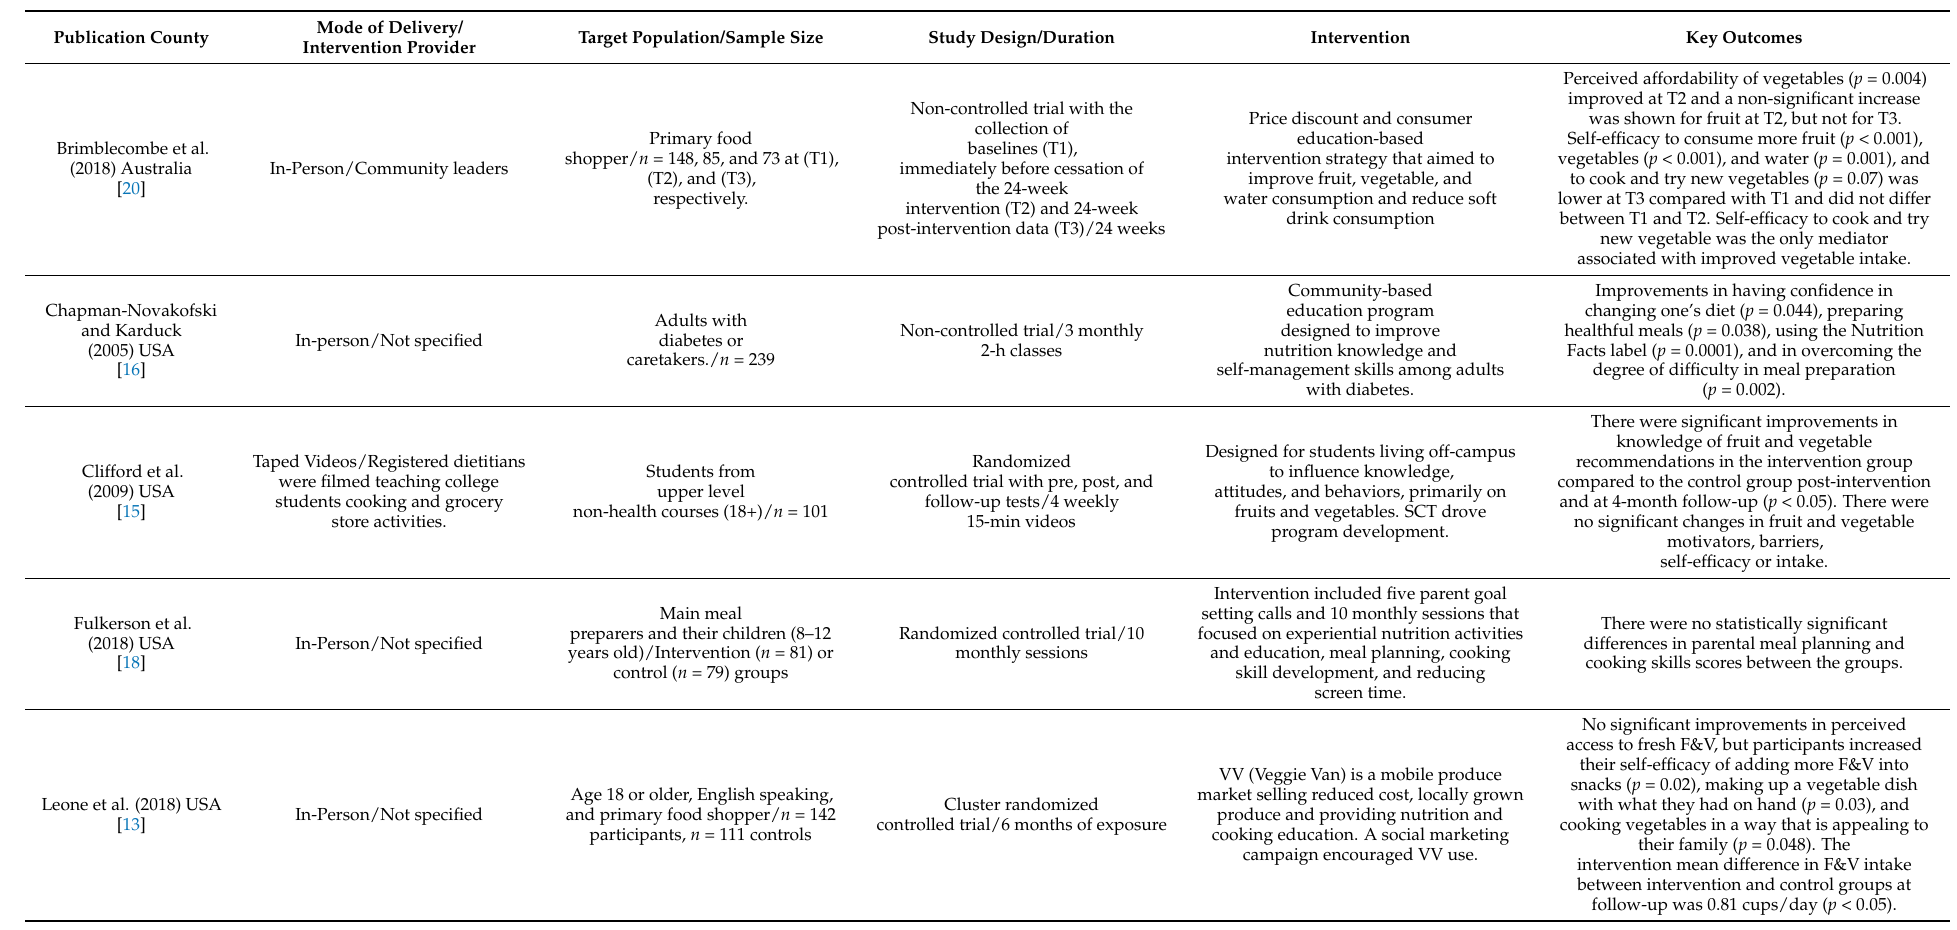
Table 2. Overview of Intervention and Study